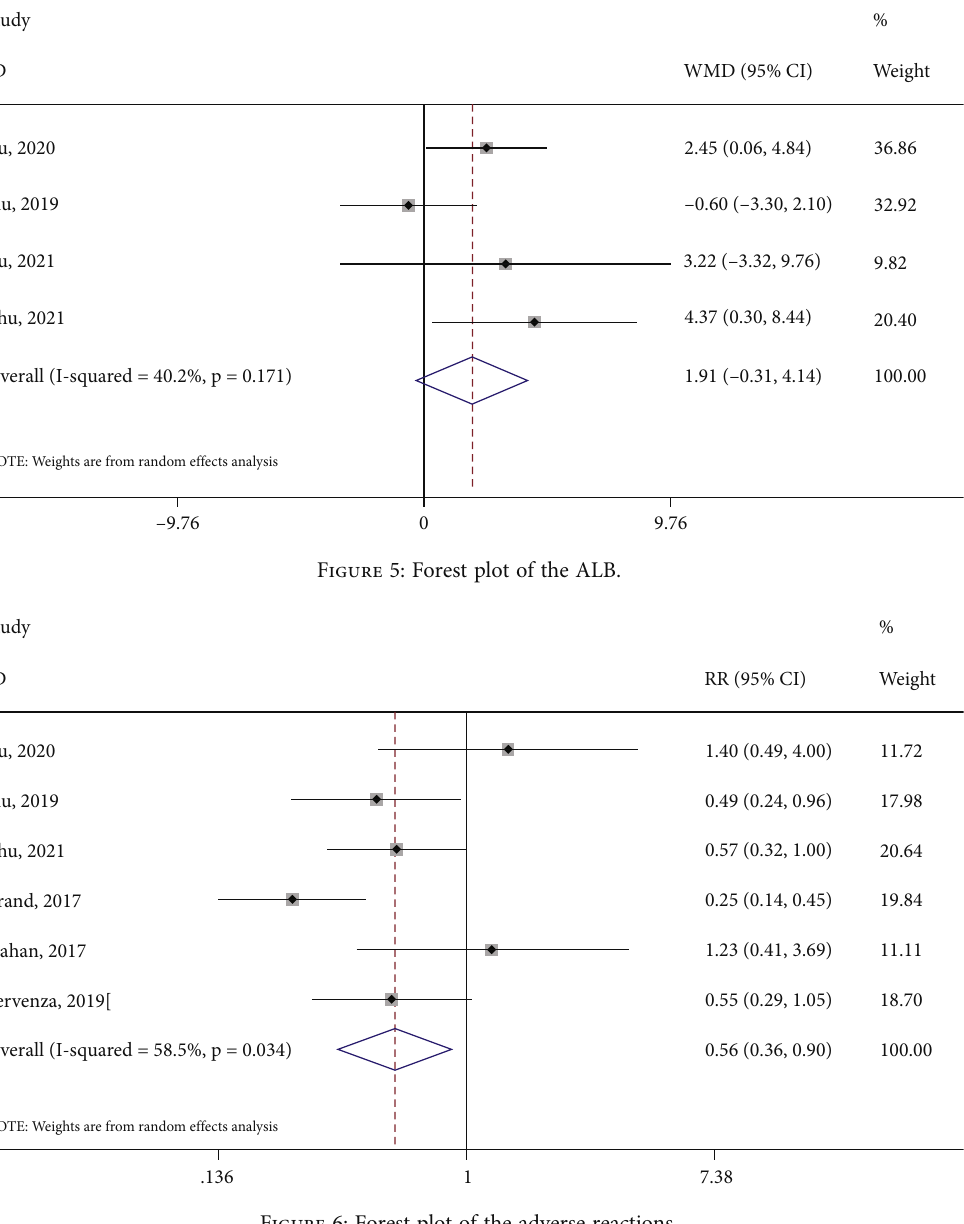
Figure 5: Forest plot of the ALB.